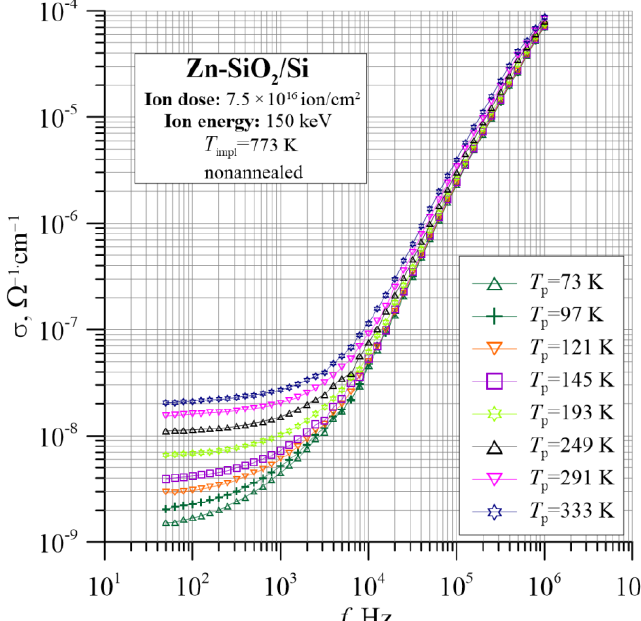
Figure 3. Temperature – frequency dependence of the conductivity σ ( f , T p ) for the Zn-SiO 2 /Si nanocomposite immediately after preparation under “hot” implantation conditions (150 keV, 7.5 × 10 16 ion/cm 2 , T impl = 773 K).